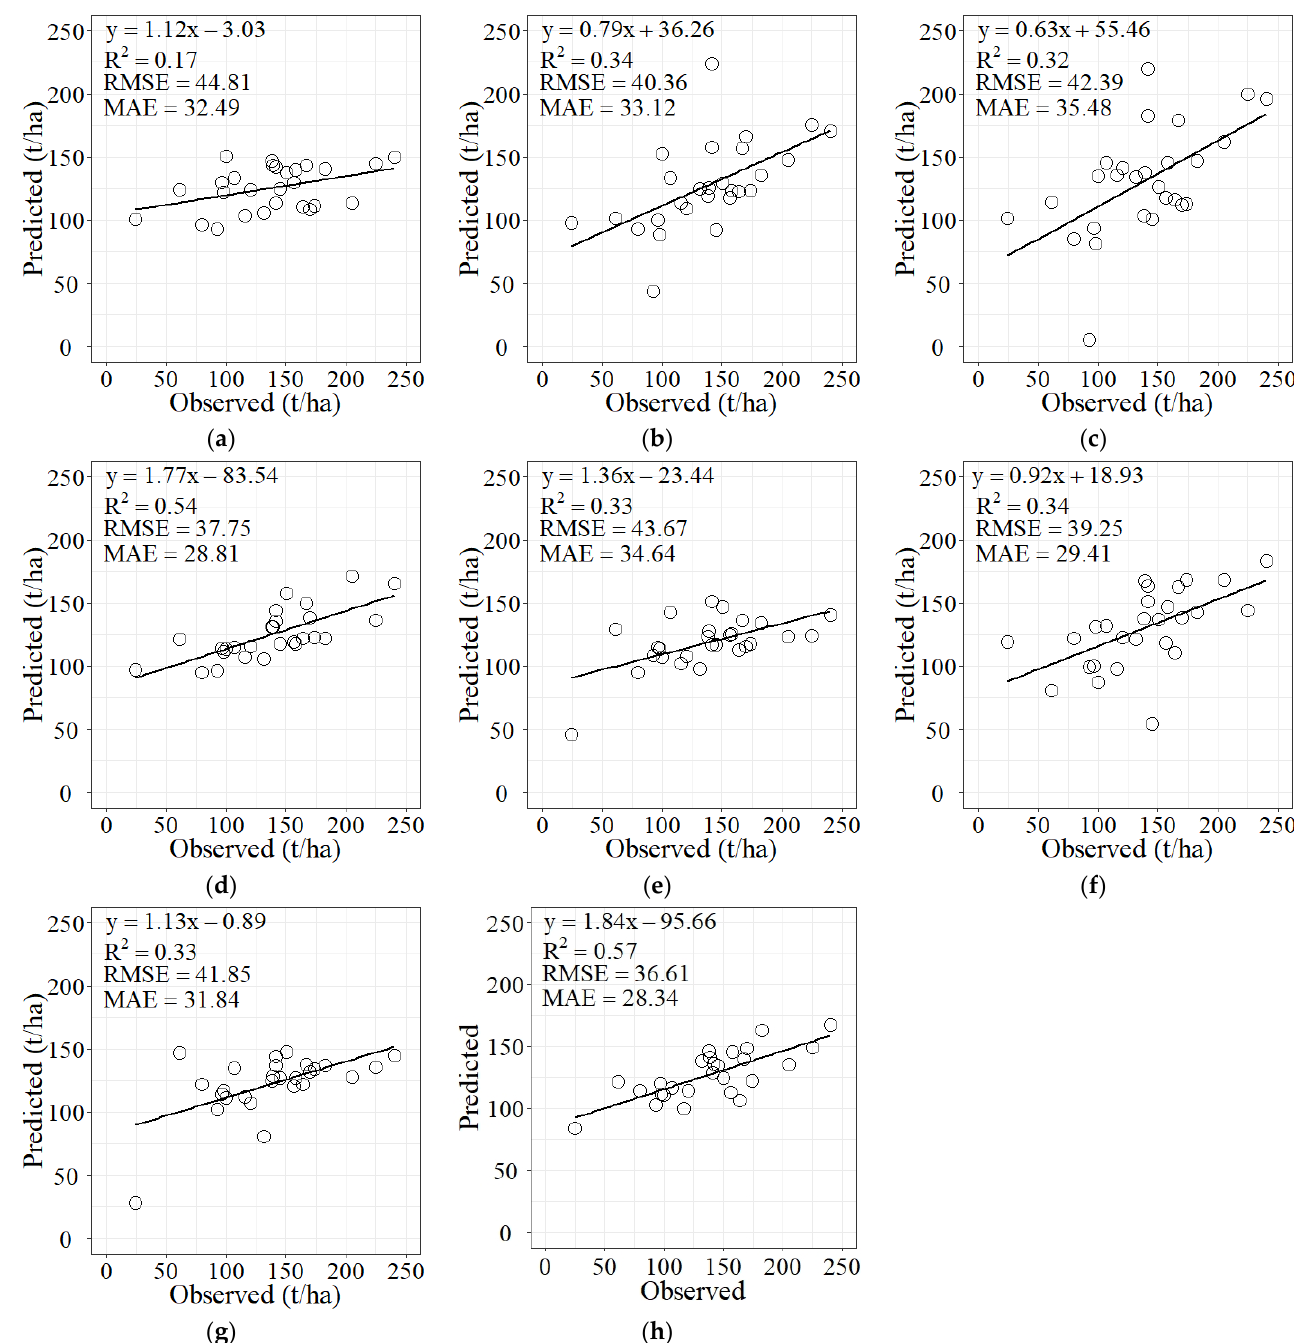
Figure 4. Scatter plots of the predicted AGB against the observed AGB values in Wangyedian using: ( a ) Landsat 8 and MLR, ( b ) Landsat 8 and SVM, ( c ) Landsat 8 and BPNN, ( d ) Landsat 8 and RF, ( e ) Landsat 9 and MLR, ( f ) Landsat 9 and SVM, ( g ) Landsat 9 and BPNN, and ( h ) Landsat 9 and RF.